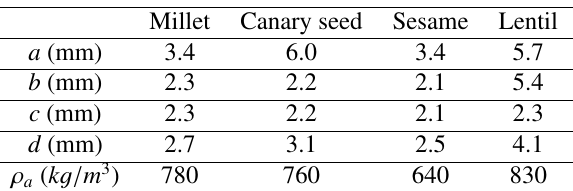
Figure 1. Schematic representation of the set-up used in the ex- periments.